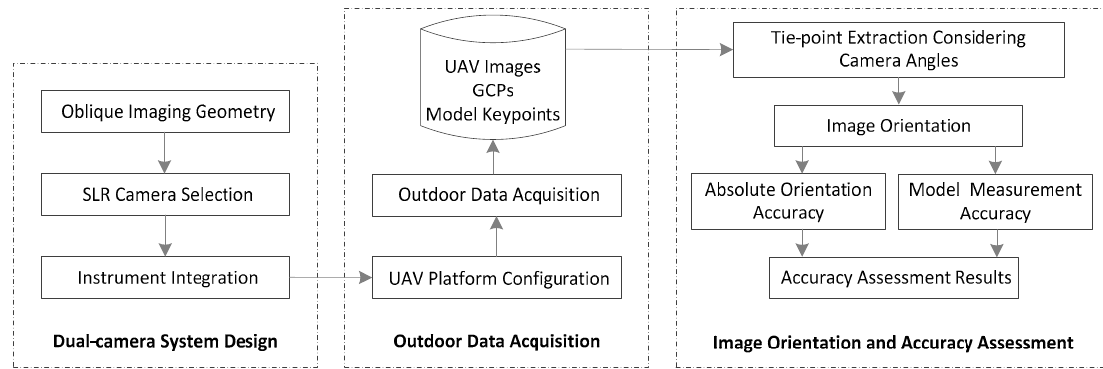
Figure 1. Technique framework for outdoor data acquisition and model accuracy assessment of transmission line based on UAV oblique photogrammetry.